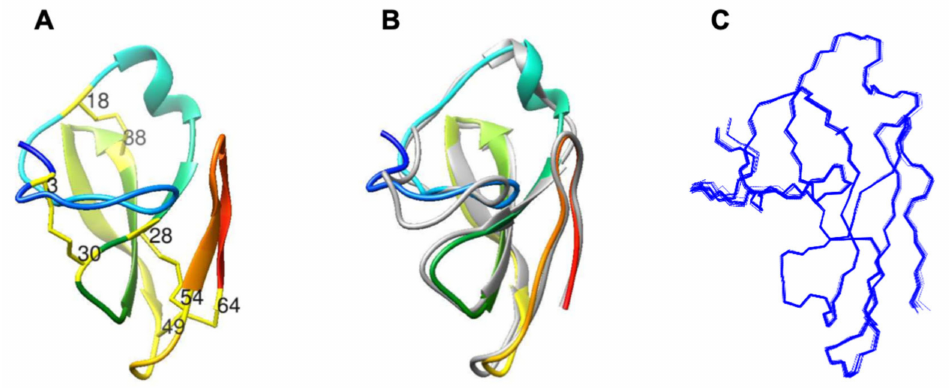
Figure 2. Comparison of the structures of Penicillium spp. MPs. ( A ) The NMR solution structure of the PAFC (pdb code 6TRM). The position of the Cys residues is indicated, and the disulfide bonds are labeled as yellow sticks. ( B ) Superimposed structures of the PAFC (pdb code 6TRM) and the P. brevicompactum BP (gray color; pdb code: 1UOY) using Chimera visualization software [33]. ( C ) Backbone NMR conformational ensemble of 20 structures of